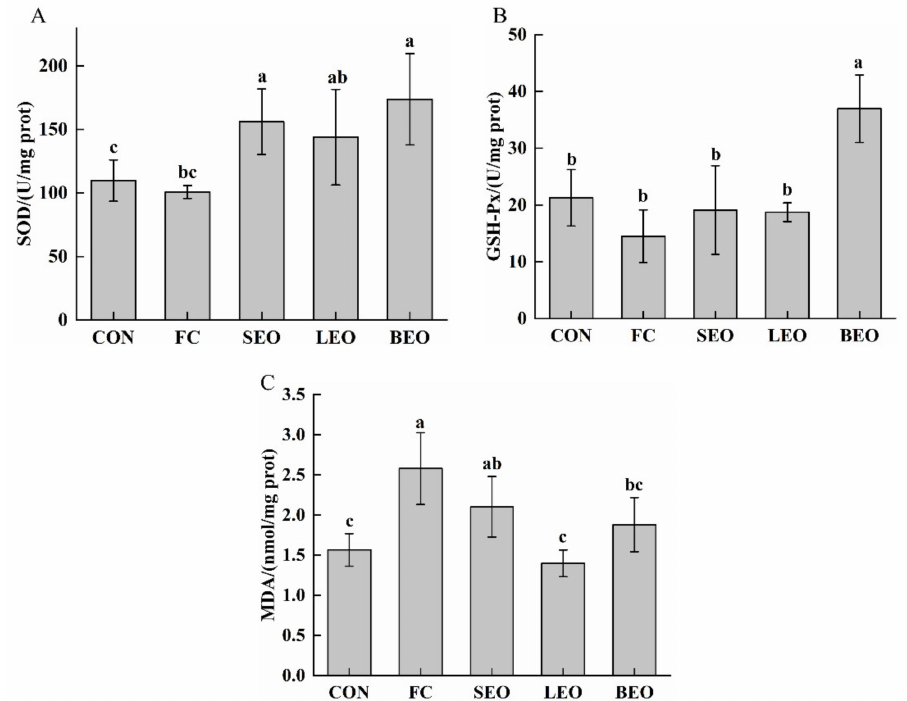
Figure 5. Effects of inhalation of the CEOs on oxidative stress in exercise-induced fatigue rats. ( A ) SOD in gastrocnemius, ( B ) GSH-Px in gastrocnemius, ( C ) MDA in gastrocnemius. Data are the means ± SD. Different lowercase letters indicate significant differences, p <